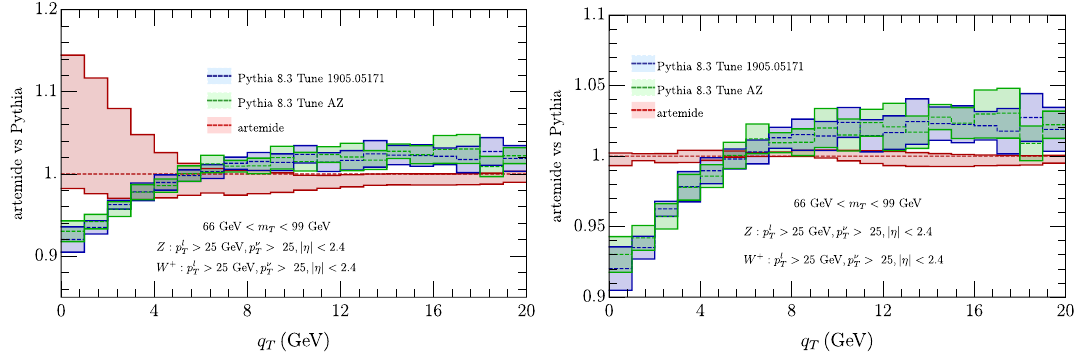
/ p W Fig. 11 Comparison of Artemide p Z ratio with Pythia 8.3 AZ tune as in [60](blue band) and as in the original ATLAS release (green band).. T T Left panels show uncorrelated errors and right panels the correlated ones. The Artemide error comes from scale variations, the Pythia errors are commented in the text